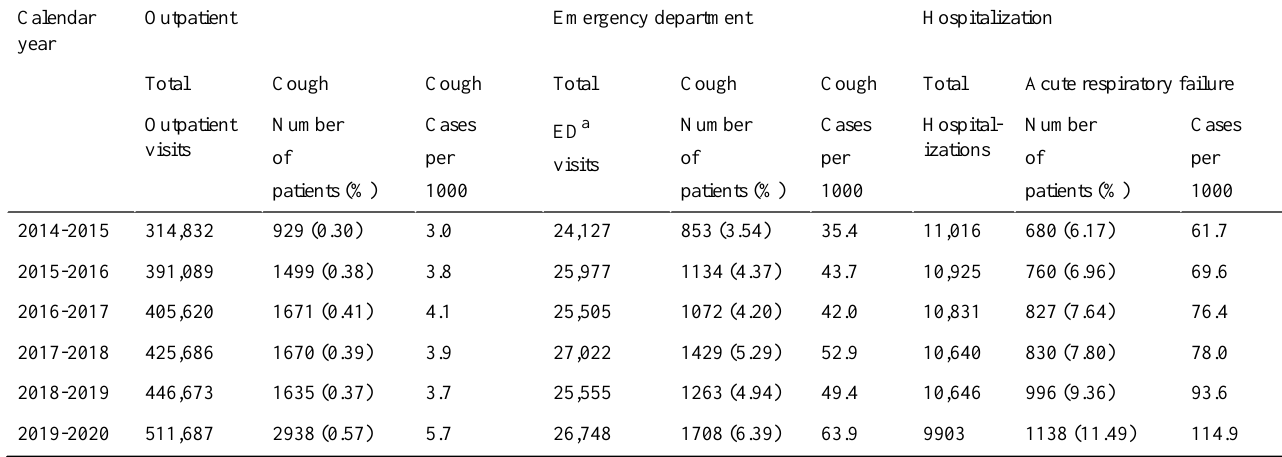
Table 1. Outpatient and emergency department visits for cough and hospitalizations for acute respiratory failure by years of winter season (December to